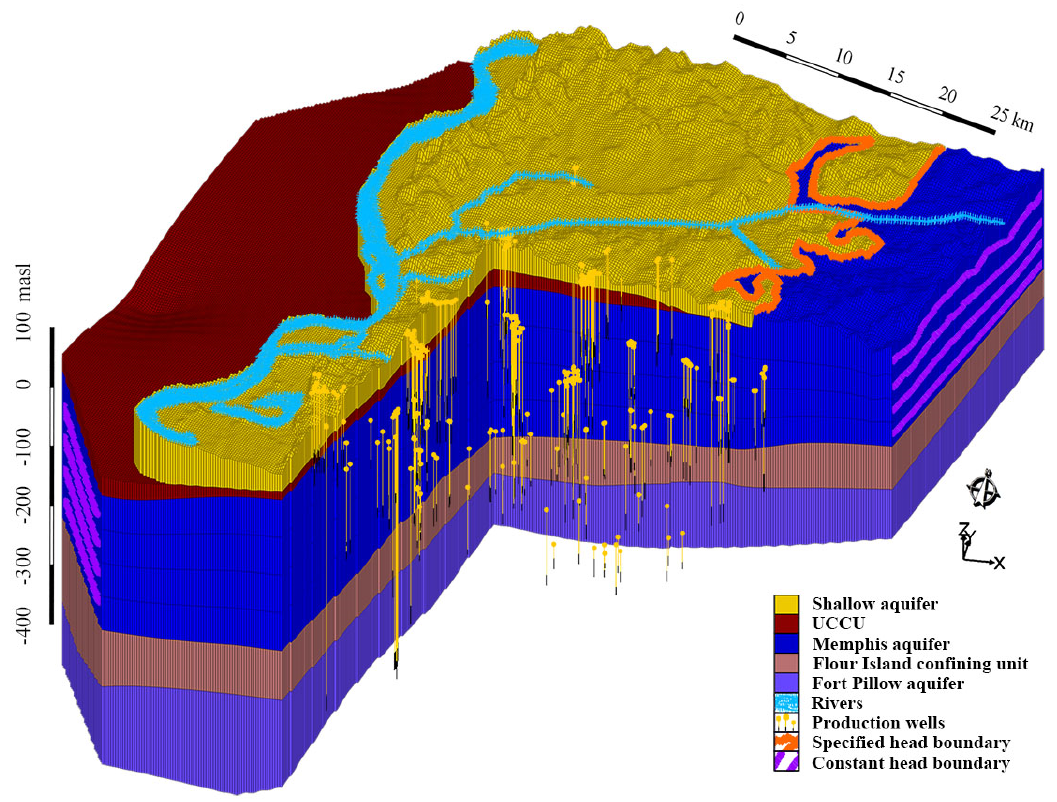
Figure 4. Oblique cut view of the 3D model showing the hydrogeologic units and the production wells (vertical yellow lines) within the aquifers.